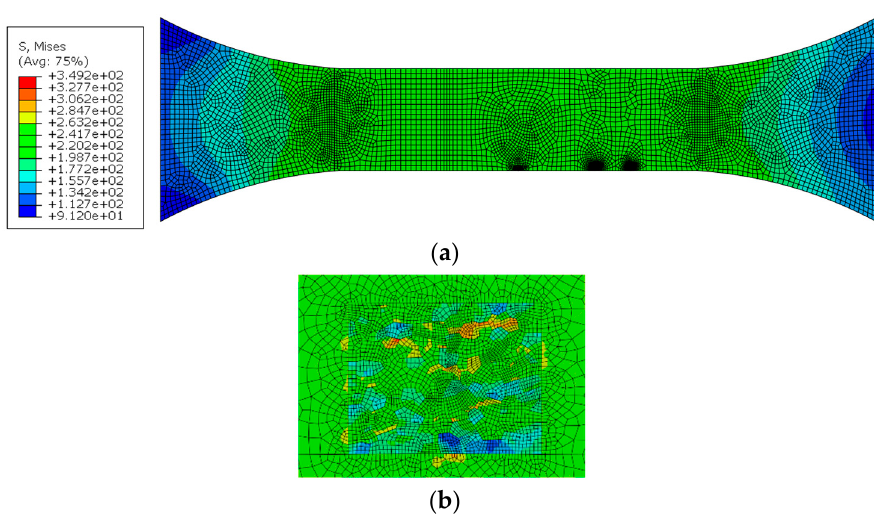
Figure 10. ( a ) Von Mises stress nephogram in the macro-mesoscopic joint model, ( b ) Von Mises stress distribution in the WNZ, MPa.